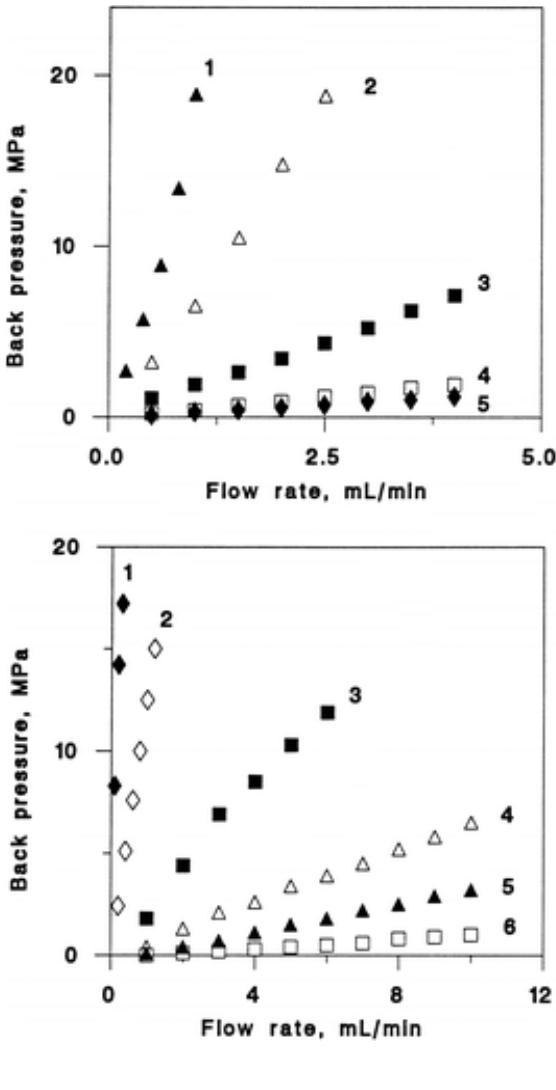
Figure 4. Effect of flow velocity on back pressure in the molded poly(glycidyl methacrylate-co-ethylene dimethacrylate) and poly(styrene-co-divinylbenzene) 100 mm × 8 mm monoliths. Conditions: mobile-phase tetrahydrofuran. (a, top) Polymerization mixture: glycidyl methacrylate 24%, ethylene dimethacrylate 16%, cyclohexanol and dodecanol contents in mixtures 54 + 6%, respectively; temperature 80 °C (1); 54 + 6, 70 °C (2); 54 + 6, 55 °C (3); 57 + 3, 55 °C (4), and 45 + 15%, 70 °C (5). (b, bottom) Polymerization mixture: styrene 20%, divinylbenzene 20%, dodecanol and toluene contents in mixtures 40 + 20%, respectively; temperature 80 °C (1); 40 + 20, 70 °C (2); 45 + 15, 80 °C (3); 45 + 15, 60 °C (4); 50 + 10, 70 °C (5) and 60 + 0%, 70 °C (6). From [3], reprinted with permission from the American Chemical